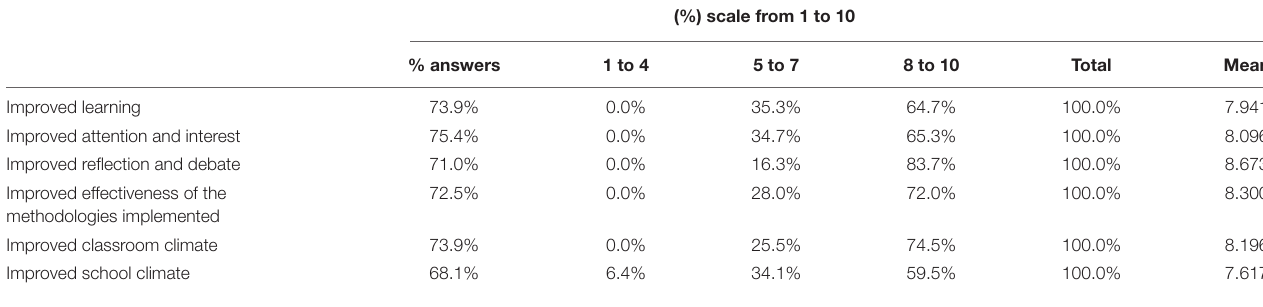
TABLE 6 | Impact of the seminar on student